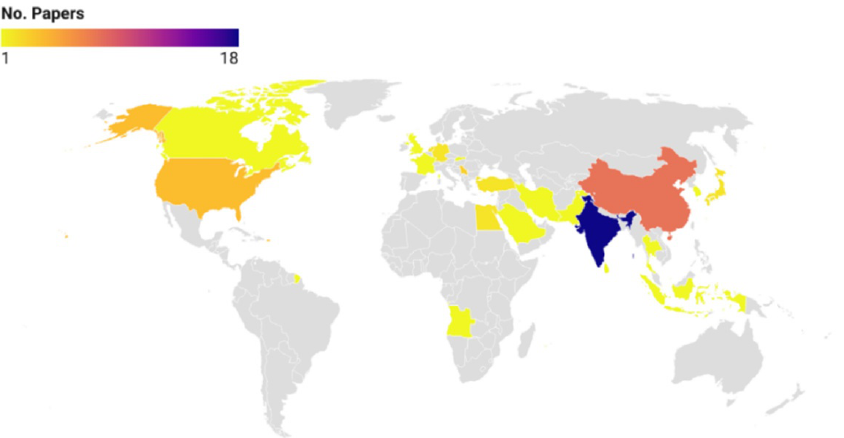
Figure 3. World map showing where the articles included in this review were produced, the corre ‐ sponding author affiliation.